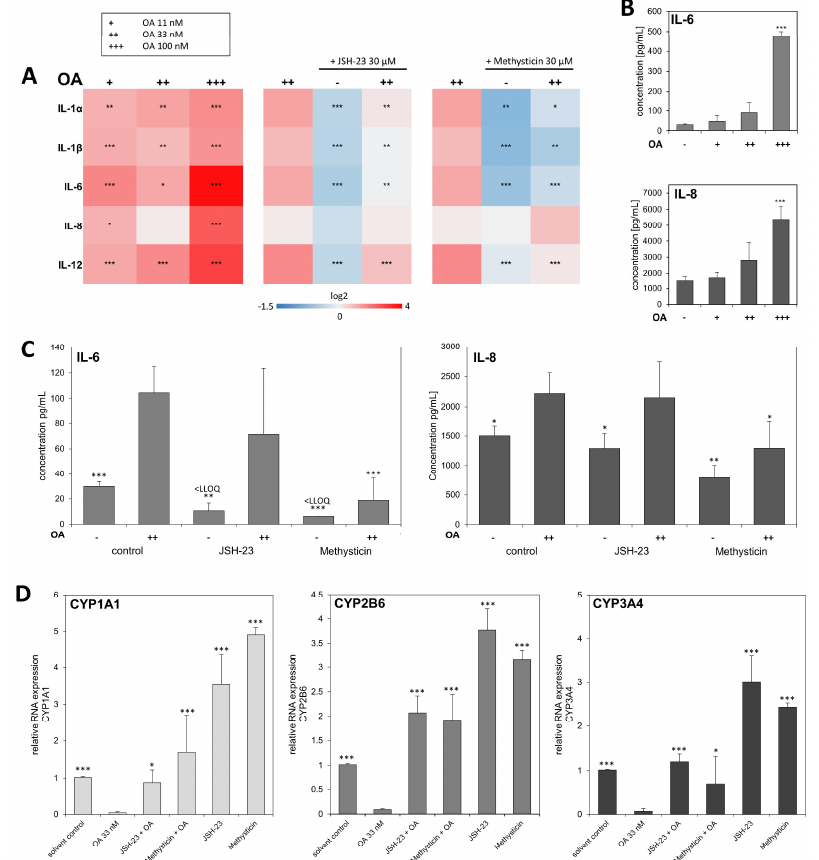
Figure 4. RNA expression and release of Interleukins in HepaRG cells after exposure to OA. Differen- tiated HepaRG cells were treated with 11, 33, and 100 nM OA alone or 33 µ M OA in combination with 30 µ M JSH-23, or 30 µ M Methysticin, two NF- κ B activation inhibitors, or with the respective solvent control for 24 h. ( A ): Analysis of mRNA levels of interleukins was performed by qPCR. The heatmap shows the log2 values of the resulting fold changes as mean of six (heatmap left) or three independent replicates, relative to the solvent control. Statistical analysis (n = 6, n = 3) was performed against the solvent control (heatmap left) or the 33 nM OA sample (rest) using one-way ANOVA followed by Dunnett’s post-hoc test (* p < 0.05; ** p < 0.01; *** p < 0.001). ( B ): Release of IL-6 and IL-8 from HepaRG cells into the cell culture supernatant after exposure to OA. The IL-content in the cell culture supernatant was quantified using Luminex multiplex assay. Statistical analysis (n = 3) was performed against the solvent control using one-way ANOVA followed by Dunnett’s post-hoc test (* p < 0.05; ** p < 0.01; *** p < 0.001). LLOQ IL-6: 12.89 pg/mL; LLOQ IL-8: 2.54 pg/mL. C : Release of IL-6 and IL-8 from HepaRG cells into the cell culture supernatant after exposure to OA in combina- tion with the inhibitors. The content in the supernatant was analyzed as described in Figure 2B. ( D ): Analysis of RNA levels of CYP1A1, CYP2B6, and CYP3A4 by qPCR in HepaRG cells after exposure